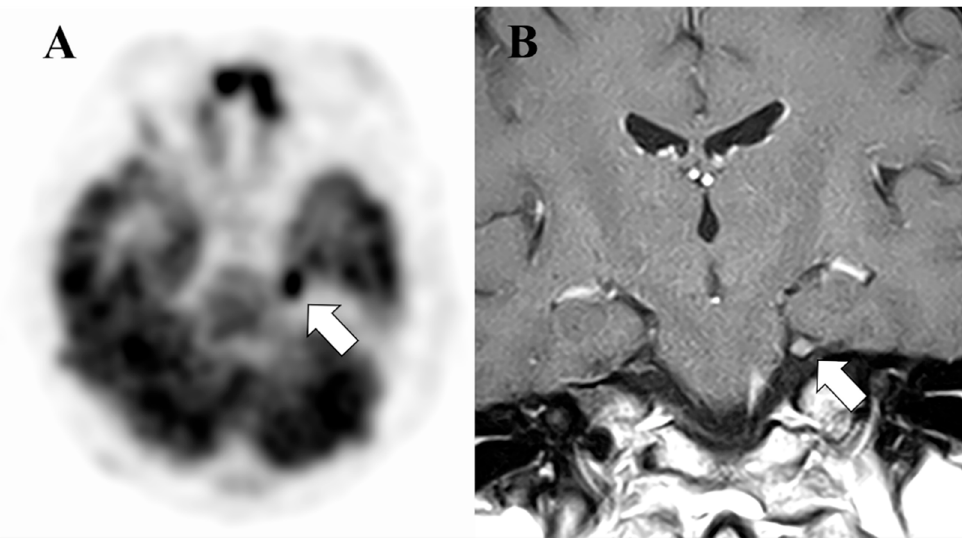
Figure 1. A 43-year-old female patient with NL . ( A ). A FDG PET image shows high accumulation in the left trigeminal nerve. ( B ). A coronal image of contrast enhanced MRI shows thickening and abnormal enhancement of the left trigeminal nerve, which was confirmed to be a true lesion.